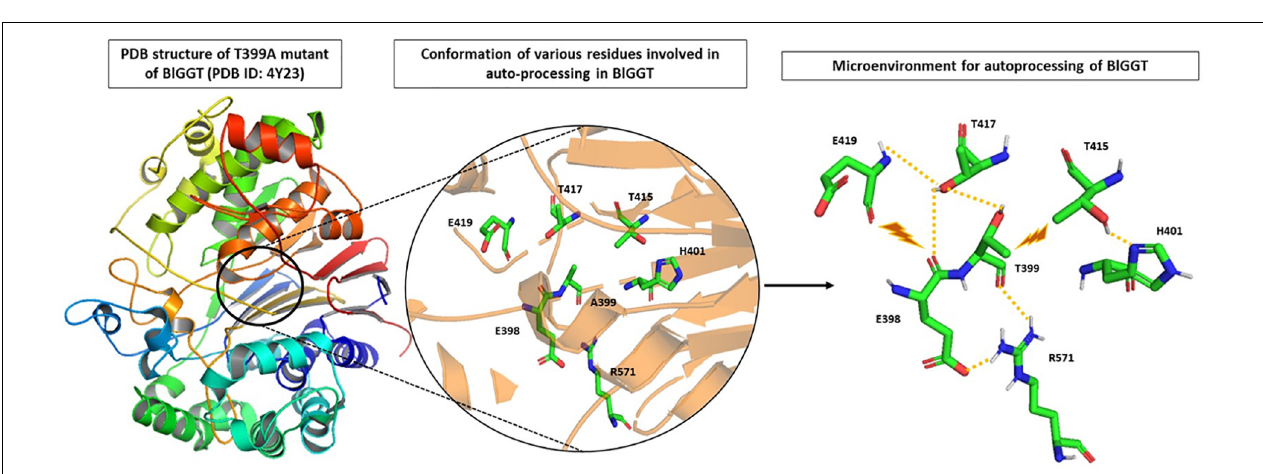
FIGURE 3 | Microenvironment for autocatalytic processing of Bacillus licheniformis gamma-glutamyl transpeptidase (BlGGT). Crystal structure of T399A precursor mutant of BlGGT (PDB ID: 4Y23) has been used for studying autocatalytic environment. A399 is replaced by T399 to show hydrogen bonding (yellow dashed lines) and steric hindrance (brown lightning bolt) experienced by T399 for its proper positioning during autoprocessing. The structures are prepared using PyMOL2